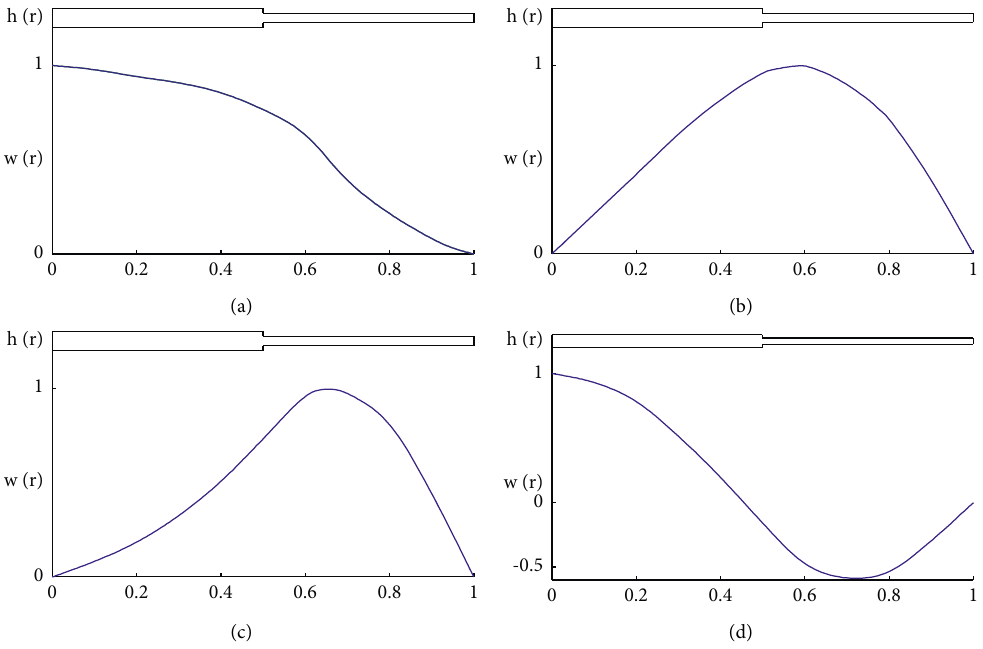
Figure 2: Modal shapes of transverse displacement for stepped circular Mindlin plate with simply supported boundary condition. (a) First mode( k , p ) � (0, 1), (b) second mode( k , p ) � (1, 1), (c) third mode( k , p ) � (2, 1), (d) fourth mode( k , p ) � (0, 2). Table 2: Dimensionless frequency parameters Ω � ω b 2 for stepped circular Mindlin plate with free boundary condition ( υ � 0 . 3 ) .